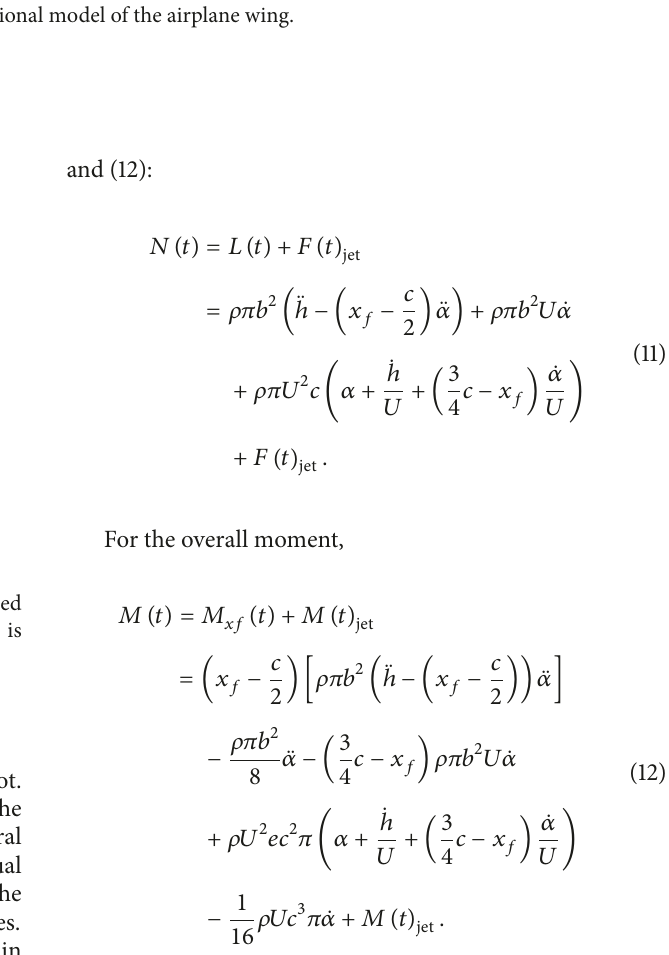
Figure 2: Two-dimensional model of the airplane wing.